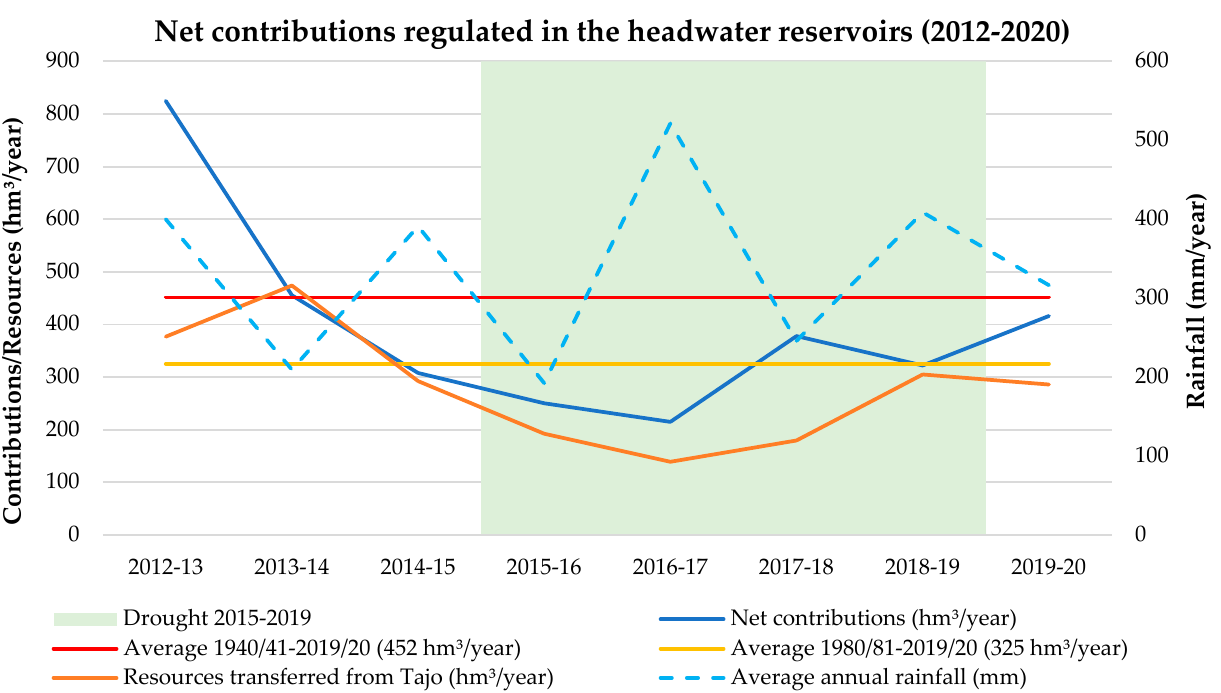
Figure 3. Net contributions regulated in the headwater reservoirs of the SRB, average annual rainfall and resources transferred from Tajo, period 2012/13-2019/20. Source: own elaboration based on [48–50].